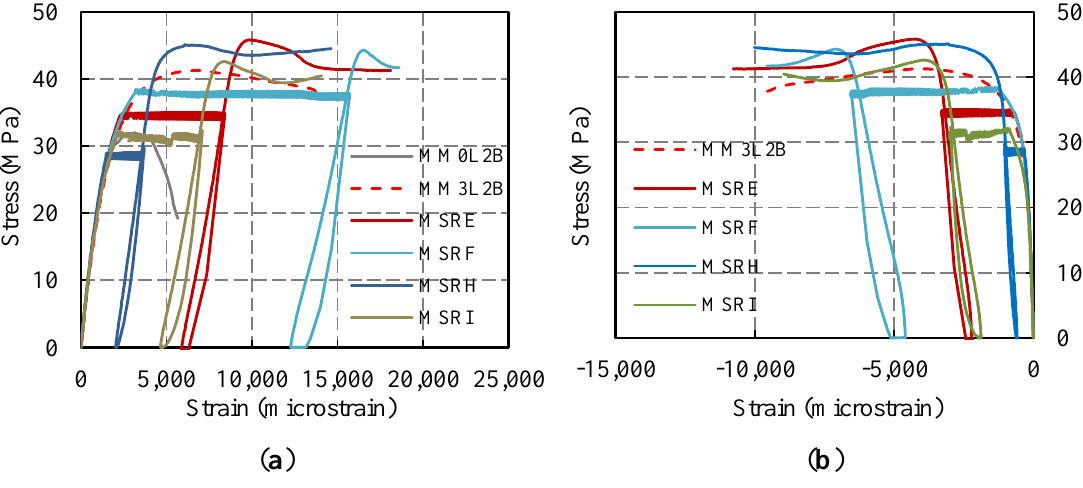
Figure 13. Medium-strength concrete residual capacity tests after 96 h of sustained